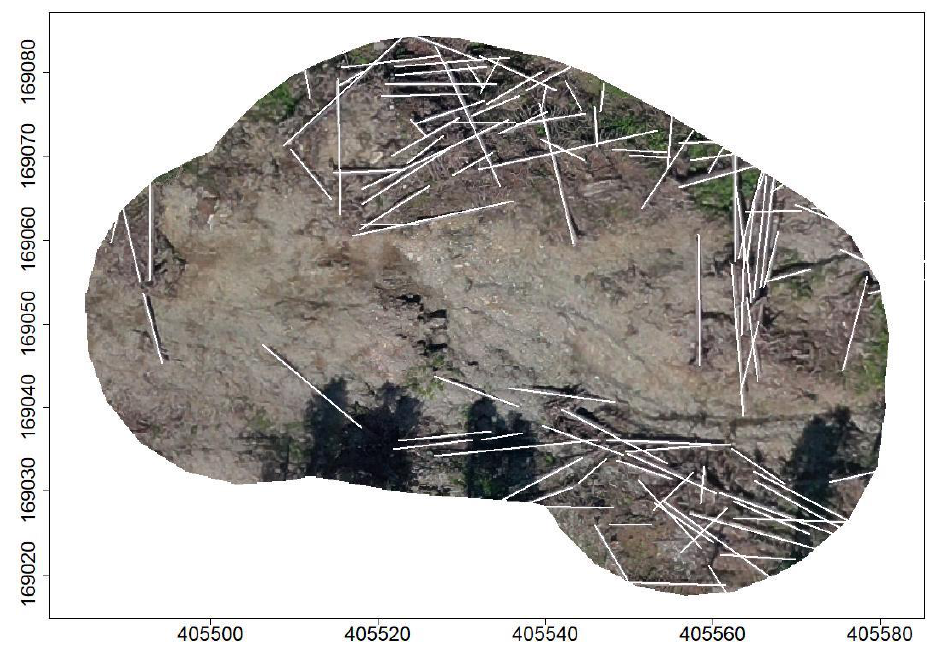
Figure 4. Manually digitized stems (white lines) on the exemplary sample site Frohn_02. Coordinates are in meters and in the “MGI / Austria GK M31” coordinate reference system (EPSG - code: 31258).